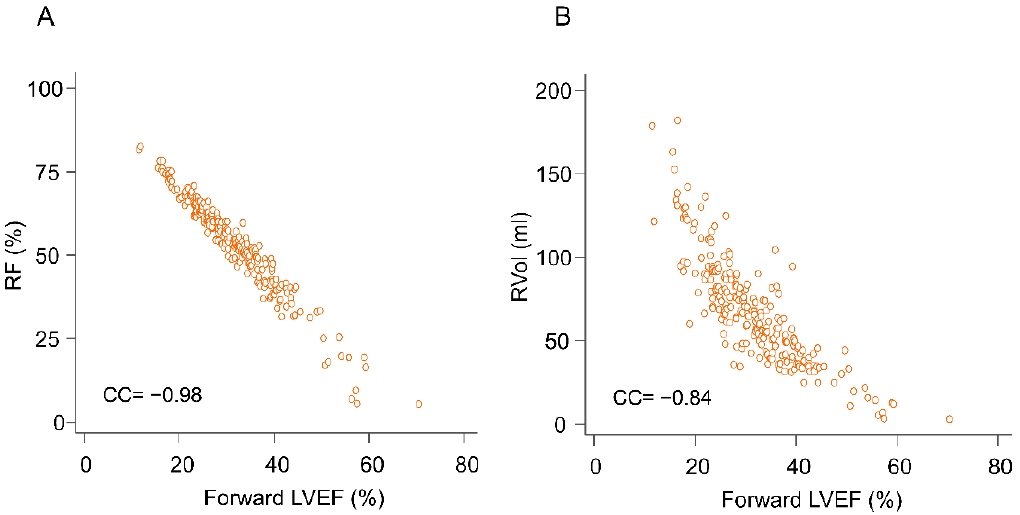
Figure 2. Correlations ( A ) between forward left ventricular ejection fraction (LVEF) and mitral regurgitant fraction (RF), and ( B ) between forward LVEF and mitral regurgitant volume (RVol).